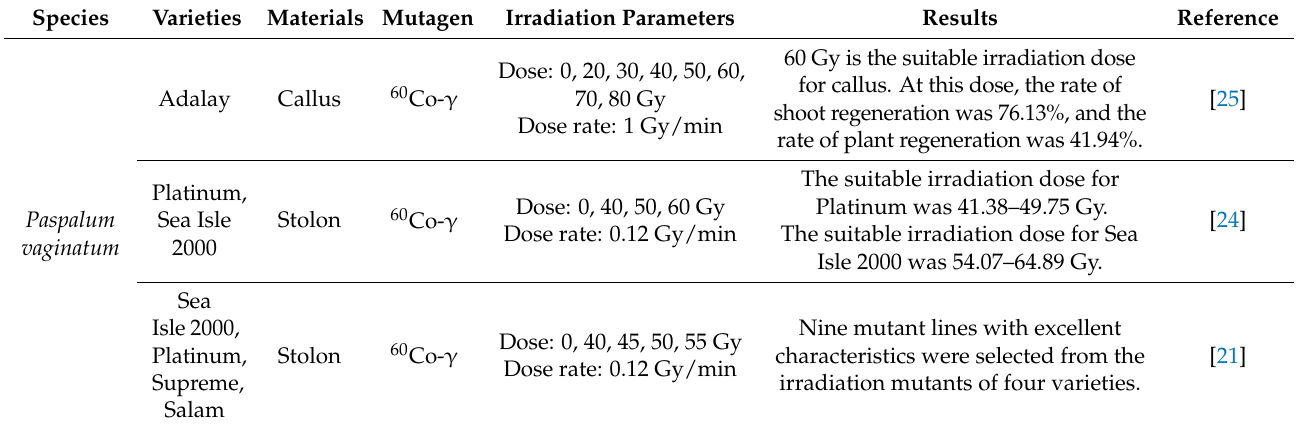
Table 1. The application of 60 Co- γ ray radiation mutagenesis on seashore paspalum.